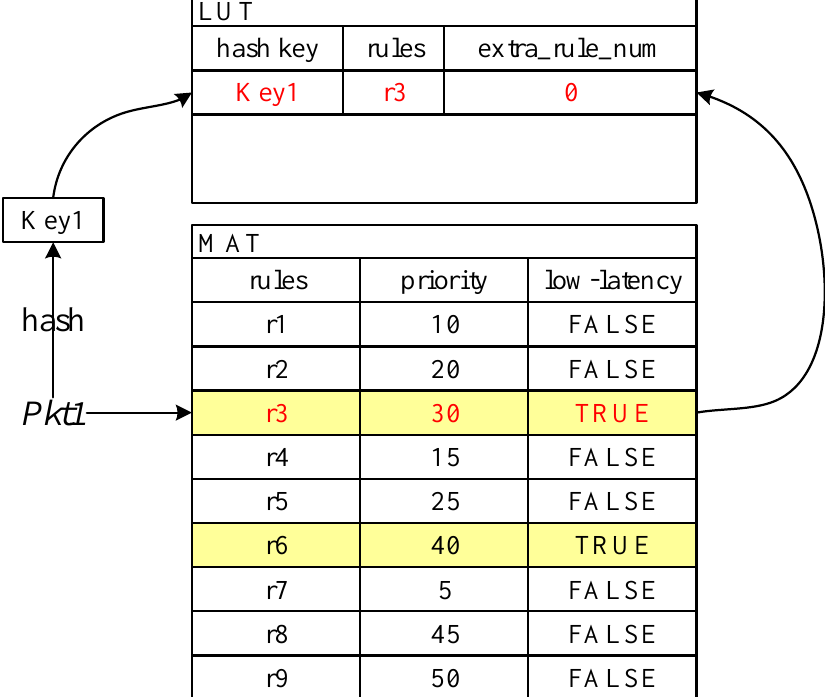
Figure 5. The updating progress of LUTs in the